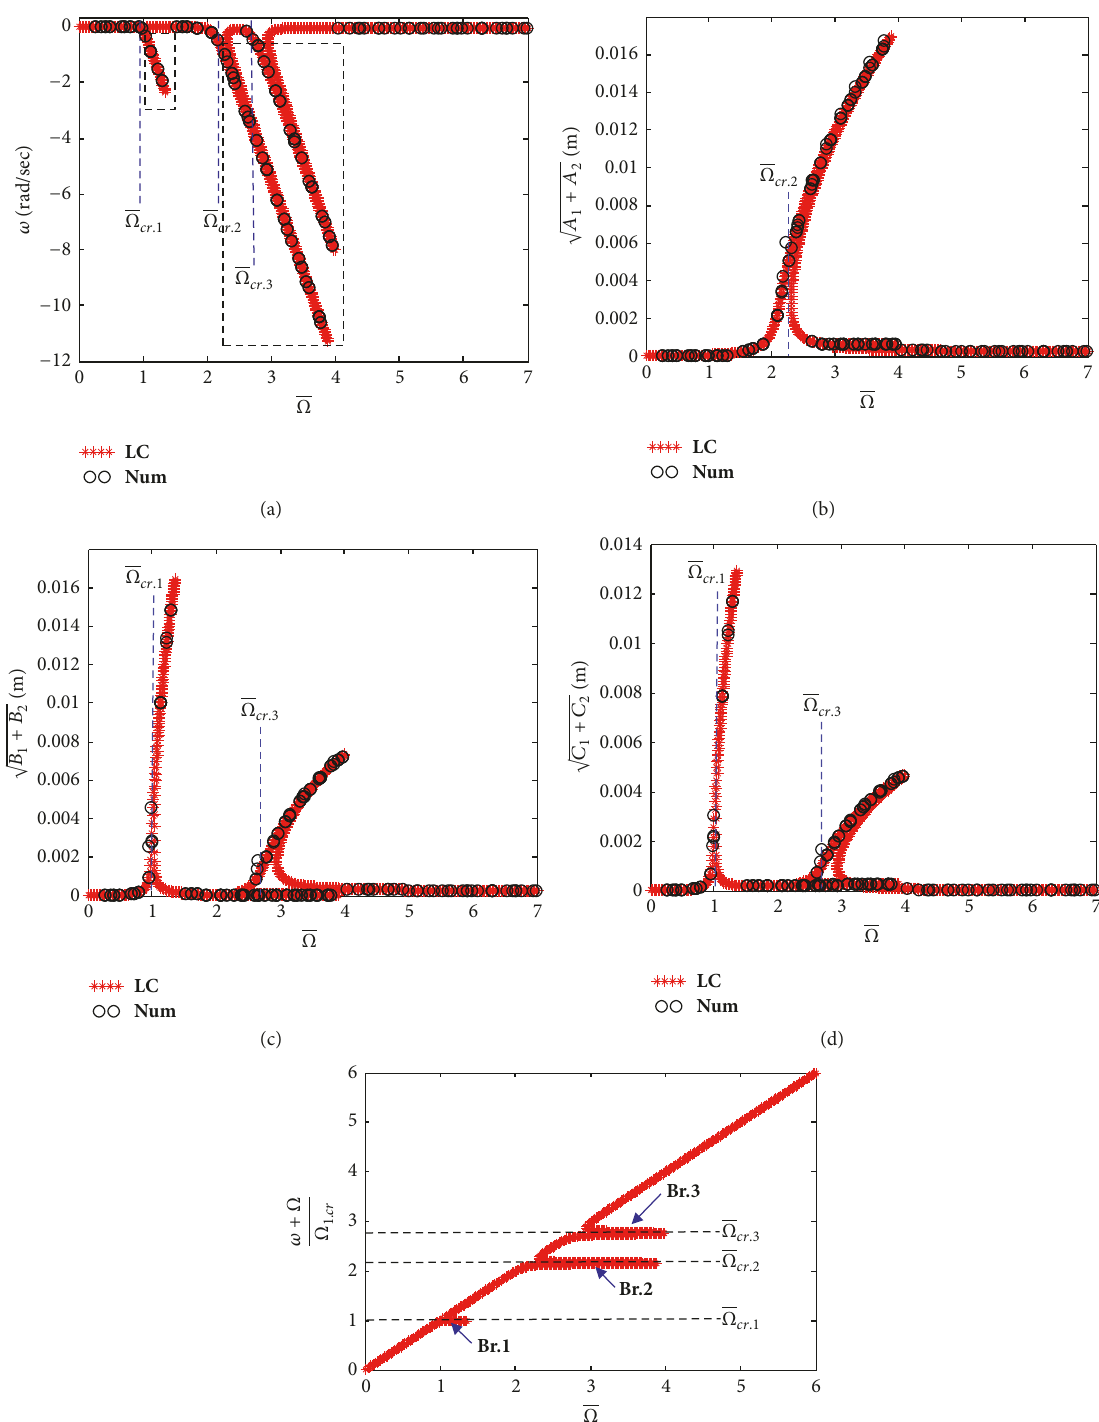
Figure 6: Extensive comparison between analytical solution (LC) and numerical simulation (Num) with the inherent nature of whirling speed of AB under limit